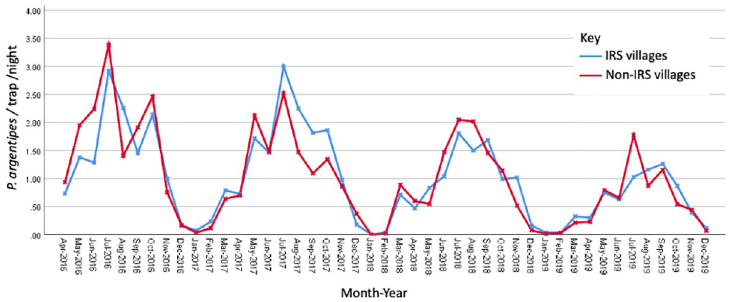
Fig 4. Aggregated P . argentipes abundance collected in all sentinel sites for IRS and non-IRS villages.